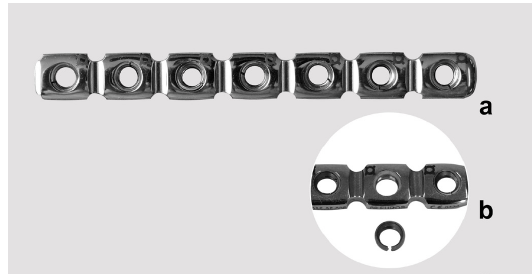
Figure 1. Seven-hole 3.5 mm locking reconstruction plate designed with locking rings inserted into the plate holes (a). Observe the locking ring that was removed of the bone plate hole (b).